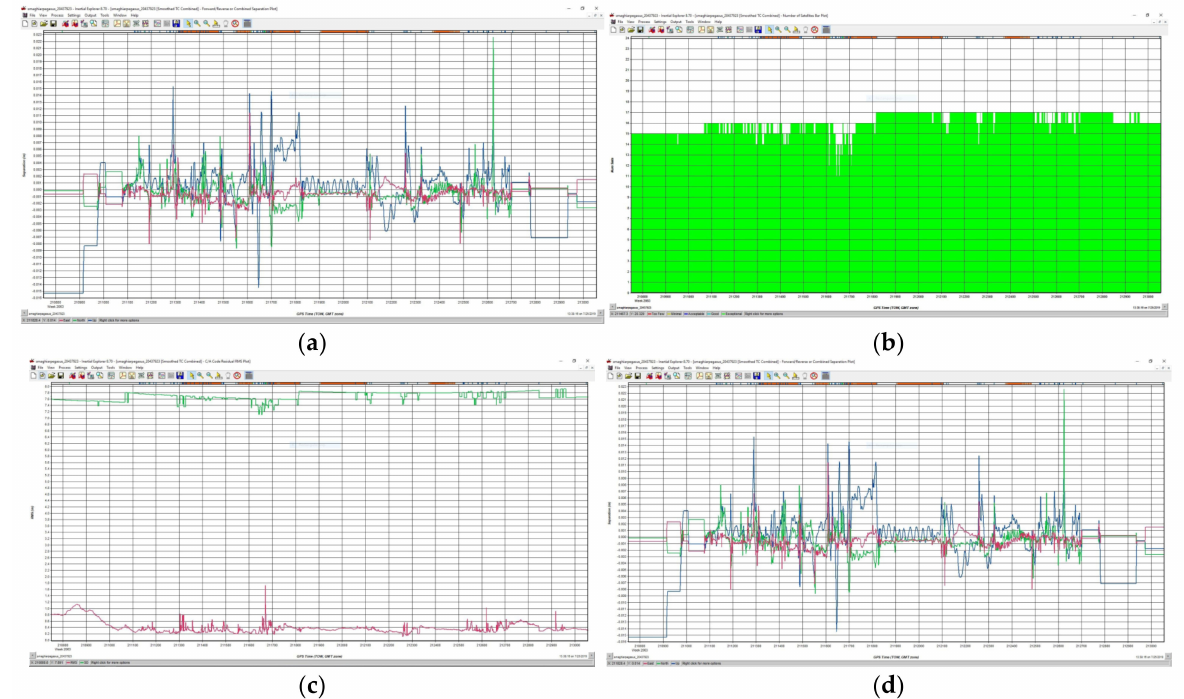
Figure 29. 3D scanning of the objective HN S Â NMARTINU MAGHIAR on 23.07.2019: ( a ) View of scan accuracy (Combined separation); ( b ) The number of visible satellites at the time of the scan; ( c ) RMS values; ( d ) PDOP values.